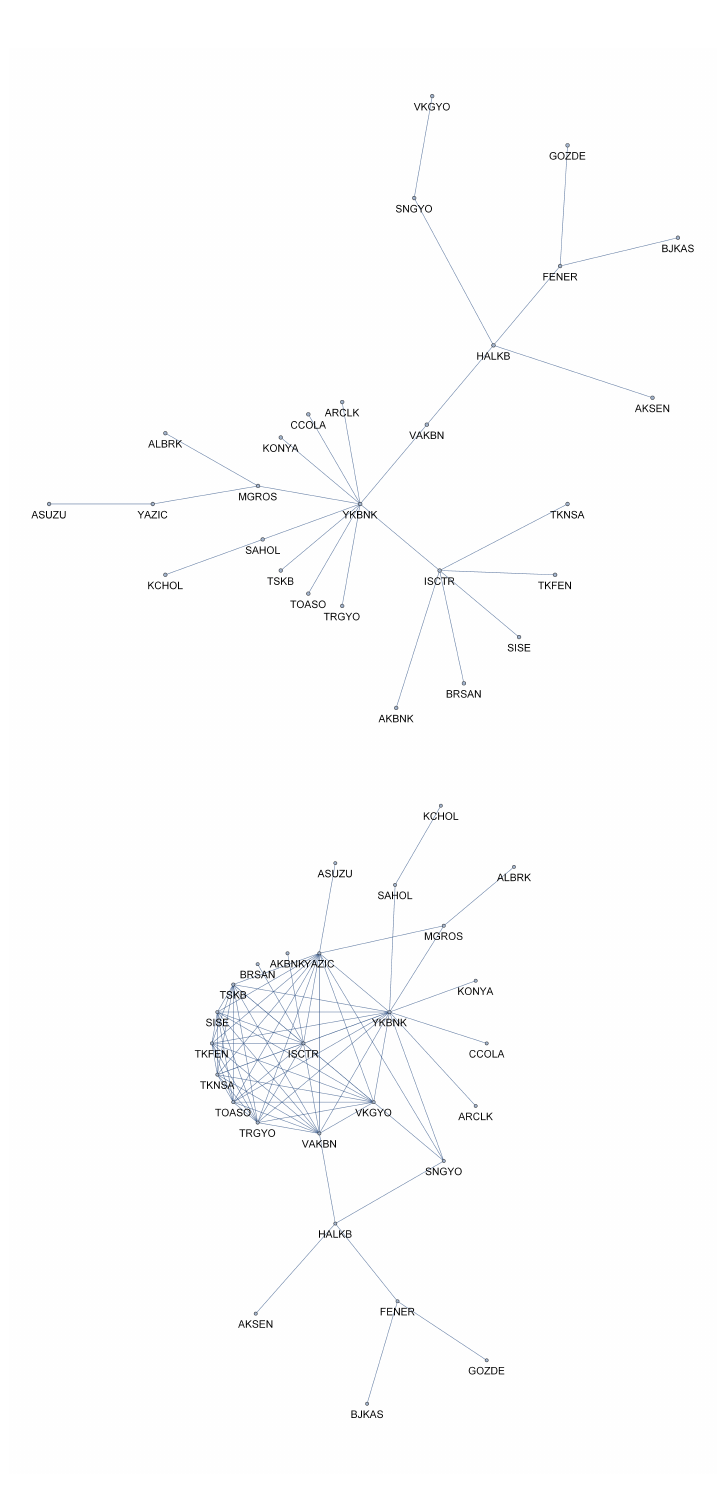
Fig. 5 MST (above) and PMFG (below) filtering of Community